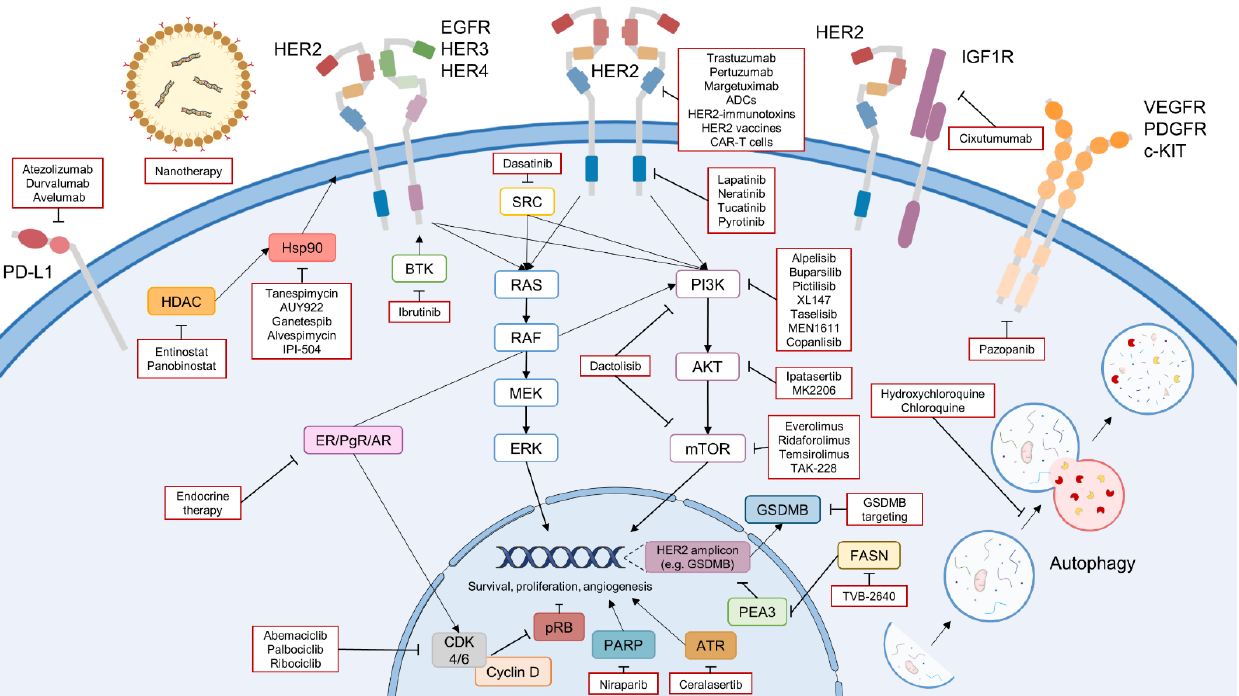
Figure 2. Overview of the novel therapeutic strategies to overcome resistance to anti-HER2 therapies in HER2 BC (highlighted in red). The figure includes the therapies under clinical validation, including novel anti-HER2 drugs (novel TKIs, antibodies, ADCs, CAR-T cells, etc.), immunotherapies, CDK4/6 inhibitors, PI3K/AKT/mTOR inhibitors, endocrine therapy, Hsp90 and HDAC inhibitors, other RTKs inhibitors, non-receptor tyrosine kinase inhibitors, FASN inhibitors, and PARP inhibitors. Furthermore, novel approaches under preclinical validation are also pointed out, such as nanotherapy, inhibition of pro-survival autophagy, and targeting of HER2 amplicon genes (e.g., GSDMB). Icons designed with smart.servier.com and Adobe Illustrator.